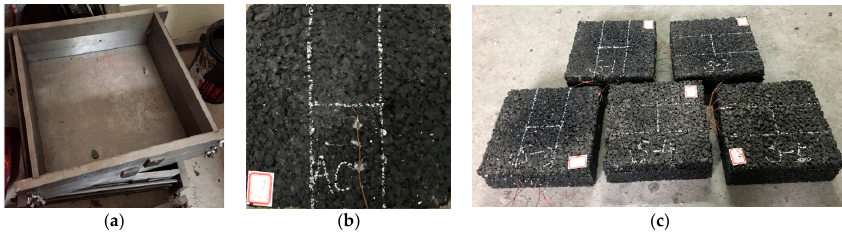
Figure 4. ( a ) Customized models; ( b ) AC specimen; ( c ) S1–S5 specimens.